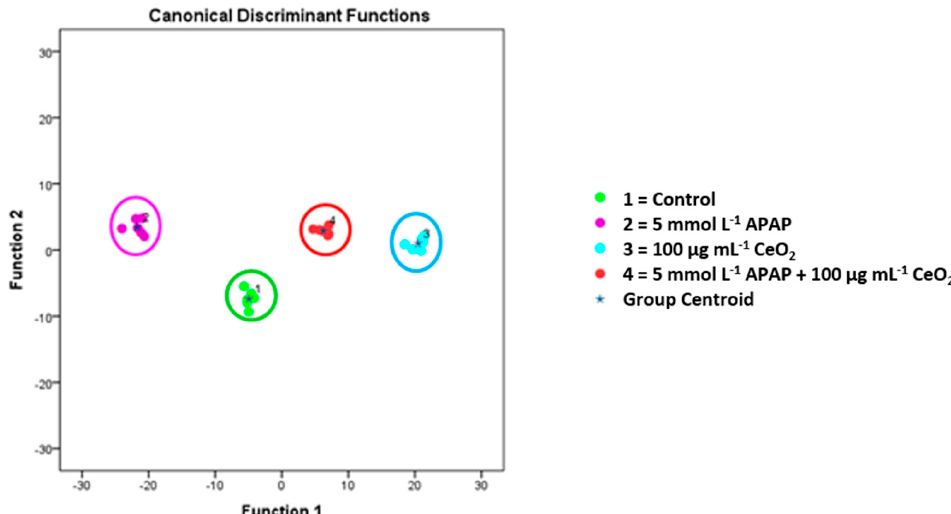
Figure 7. Metabolic changes of cell membrane lipid patterns of HuH-7 cells after treatment with APAP (5 mmol L − 1 ), CeO 2 NPs (100 µg/mL) and APAP (5 mmol L − 1 ) plus CeO 2 NPs (100 µg/mL), as identified by means of ToF-SIMS in combination with multivariate data analysis. The diagram shows the values of the discriminant scores obtained from Fisher’s discriminant analysis of 24 HuH-7 samples. The model was evaluated using the “leave-one-out” formalism (100% correct grouping of ungrouped cases).